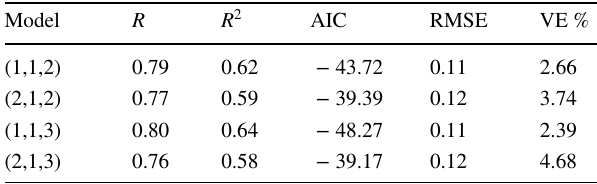
Table 3 The consequences of HCO